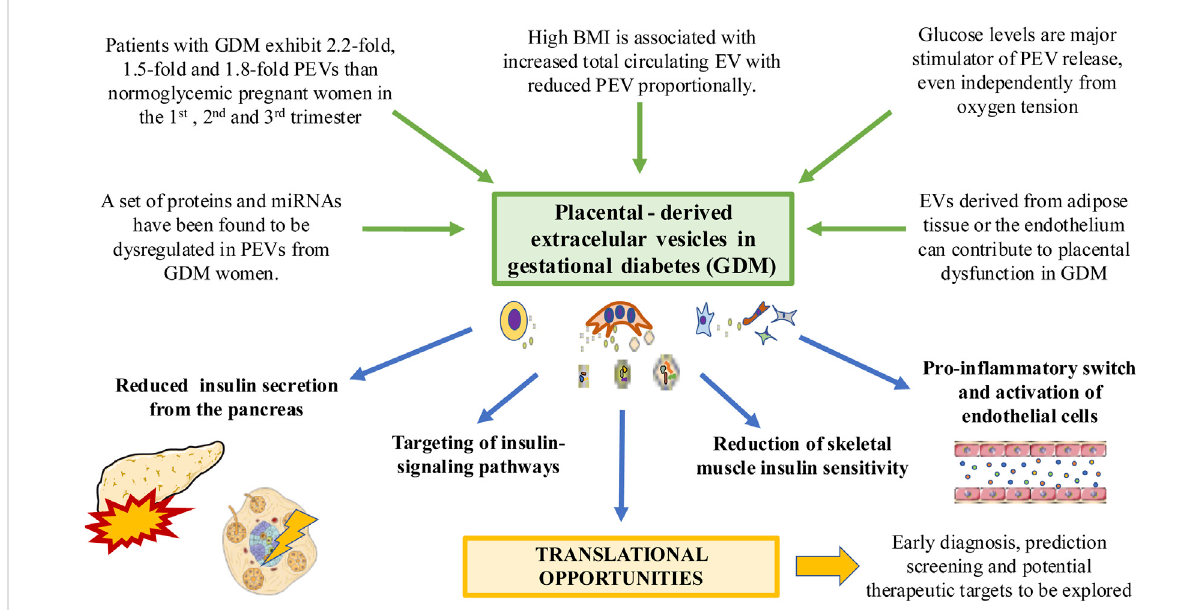
FIGURE 3 The relevance of PEVs in the context of GDM. Different factors associated with this condition such as hyperglycemia and high body mass index can induce signi fi cant changes in PEV pro fi le. EVs from other tissues affected by GDM such as adipose tissue can induce changes in the placenta. PEVs can in turn reduce insulin secretion from the pancreas, altering insulin signaling pathways and insulin sensitivity in different tissues such as the muscle or endothelium, driving to its activation and pro-in fl ammatory switch. Translational knowledge will help to improve the clinical management of GDM